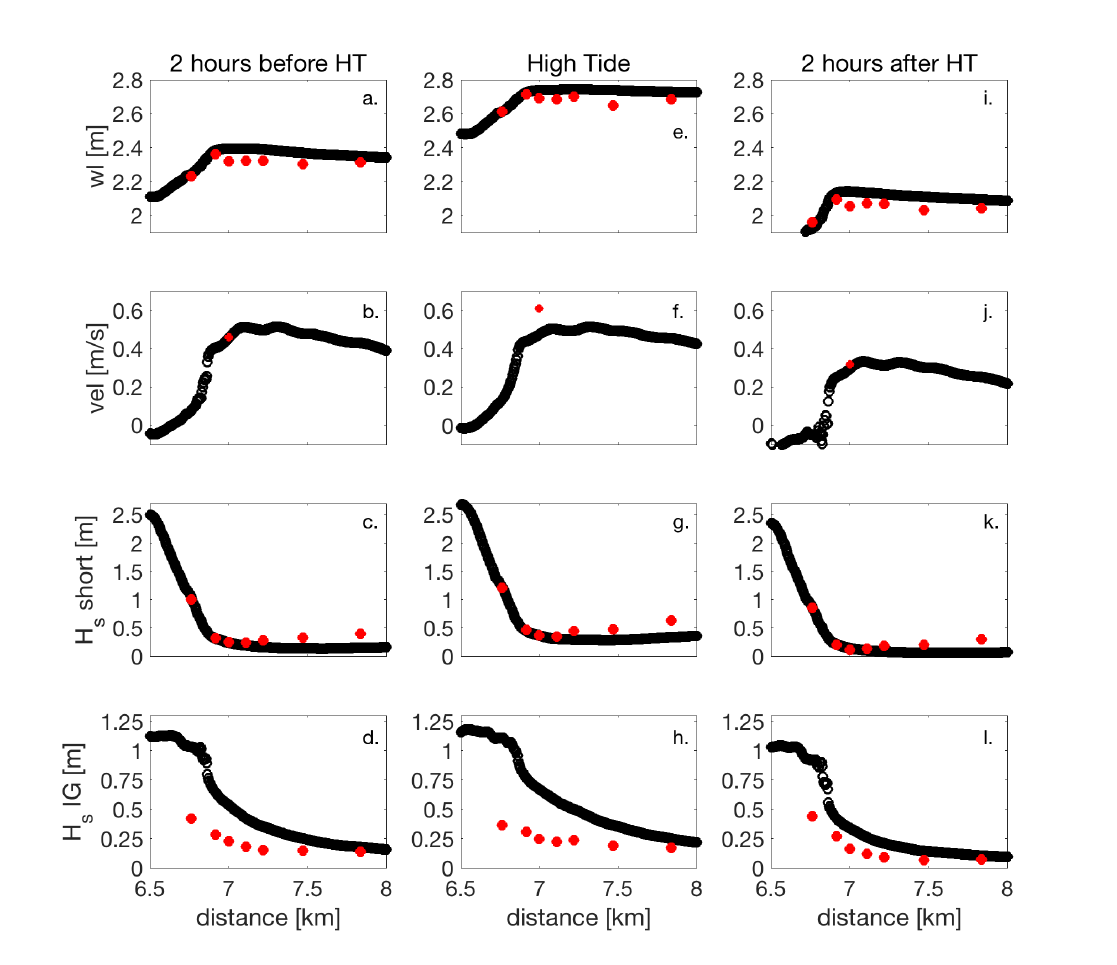
Figure A1. Observed (red) and modeled (black) water levels (wl, a , e , and i ), cross-shore velocities (vel, b , f , and j ), short ( c , g , and k ) and IG ( d , h , and l ) significant wave heights (Hs) from 2 h before to 2 h after high tide (HT) for flooding 1. The North Sea is to the left and the Wadden Sea to the right in this